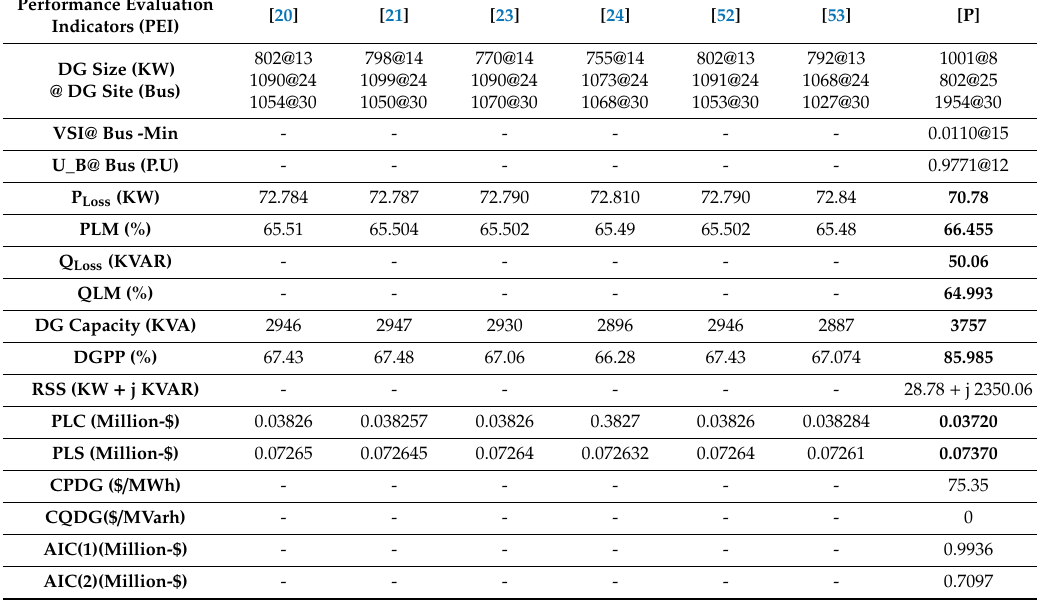
Table 11. Comparisons of results with various scenarios of case 1 for 33-bus test system (DG@PF = 1). Performance Evaluation Indicators